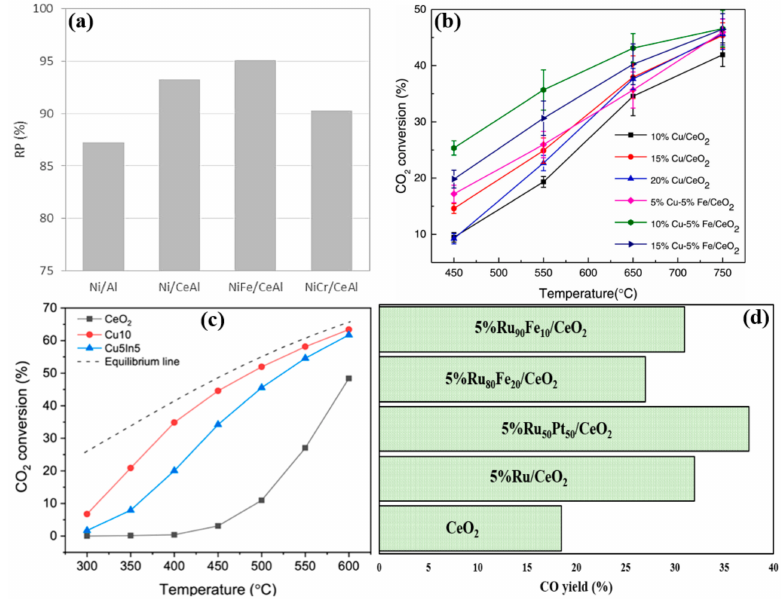
Figure 17. Effect of bimetallic on metal-CeO 2 in RWGS reaction: ( a ) NiFe-CeO 2 , reprinted with permission from [167]. Copyright Elsevier, 2018, ( b ) CuFe-CeO 2 , reprinted with permission from [177]. Copyright Elsevier, 2021, ( c ) CuIn-CeO 2 , reprinted with permission from [91]. Copyright ACS, 2022, ( d ) CO yield for RuPt/CeO 2 and RuFe/CeO 2 at 600 ◦